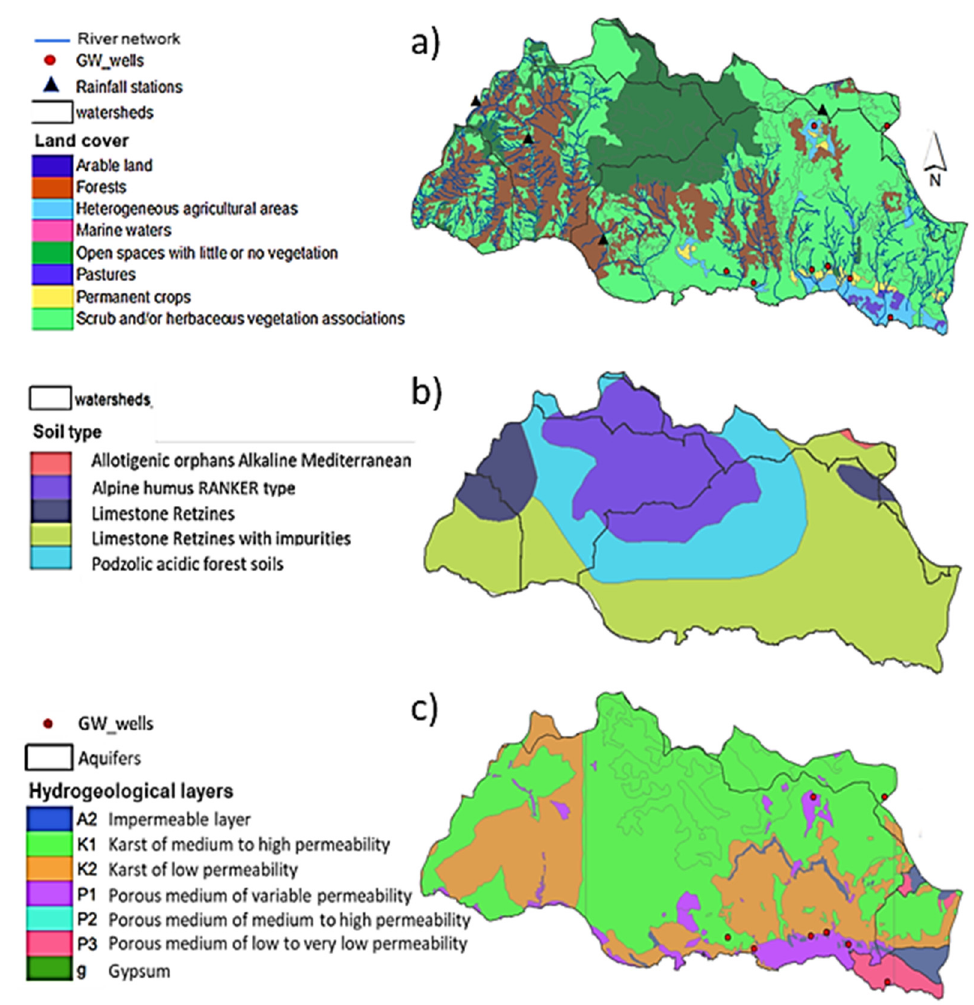
Figure 10. Land cover ( a ), soil types ( b ) and hydrological layers ( c ) in of the Municipality of